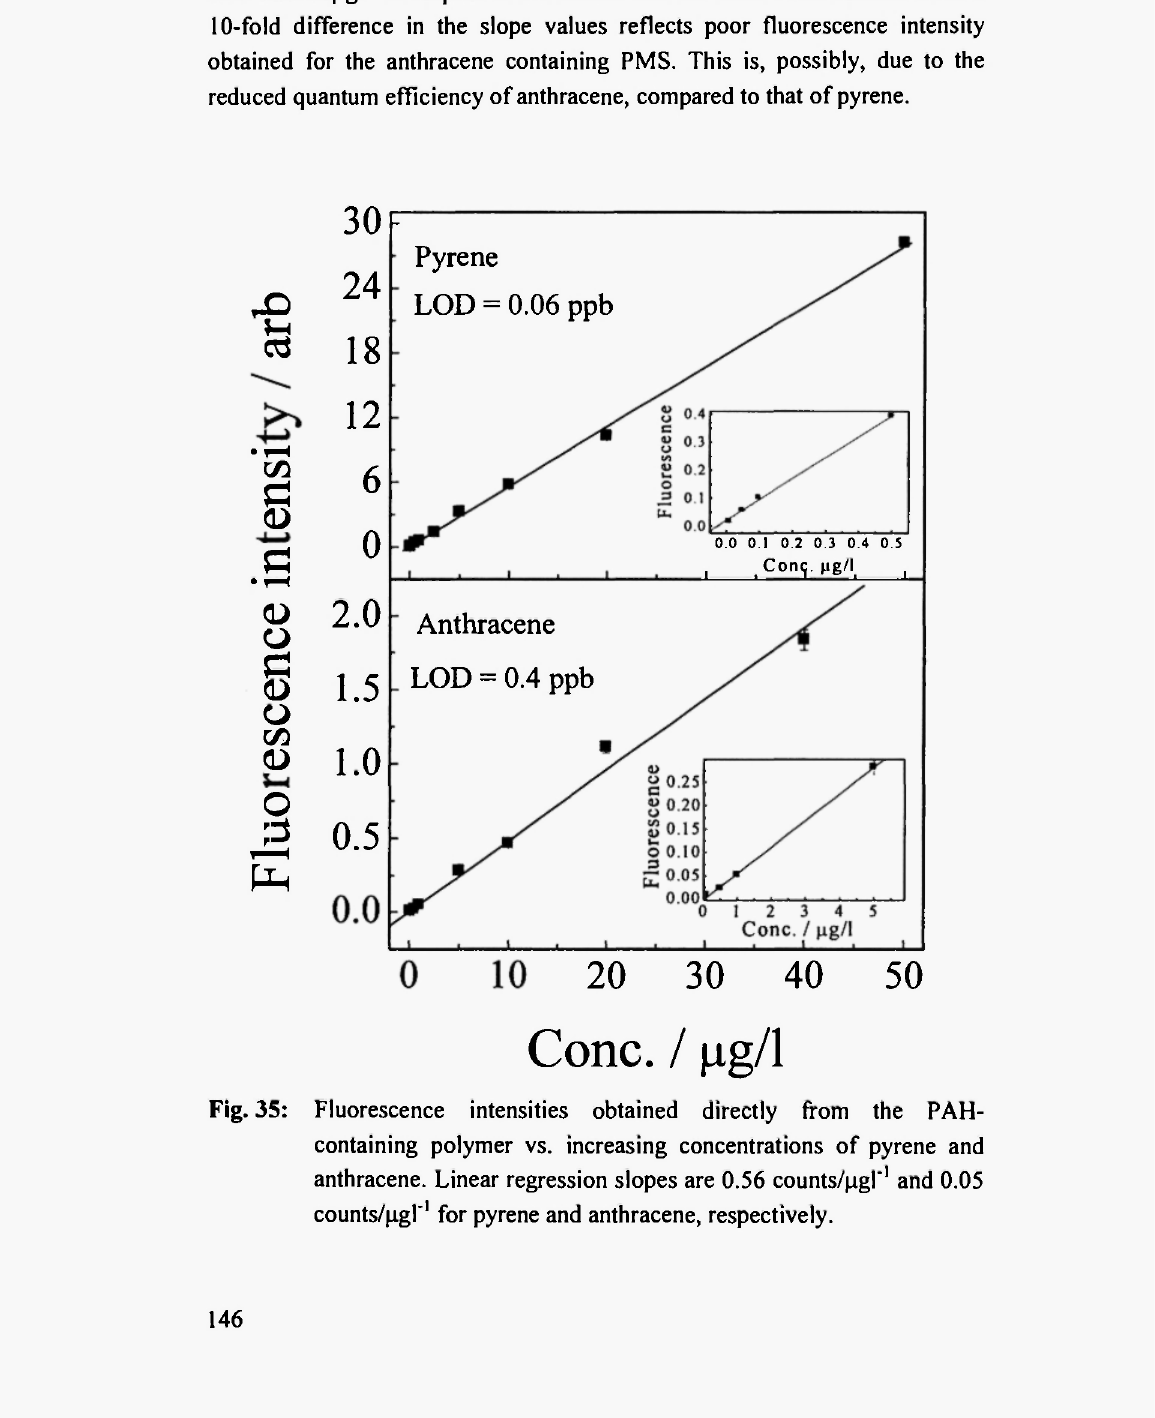
Fig. 35: Fluorescence intensities obtained directly from the PAH- containing polymer vs. increasing concentrations of pyrene and anthracene. Linear regression slopes are 0.56 counts/^gl" 1 and 0.05 counts^gl' 1 for pyrene and anthracene,